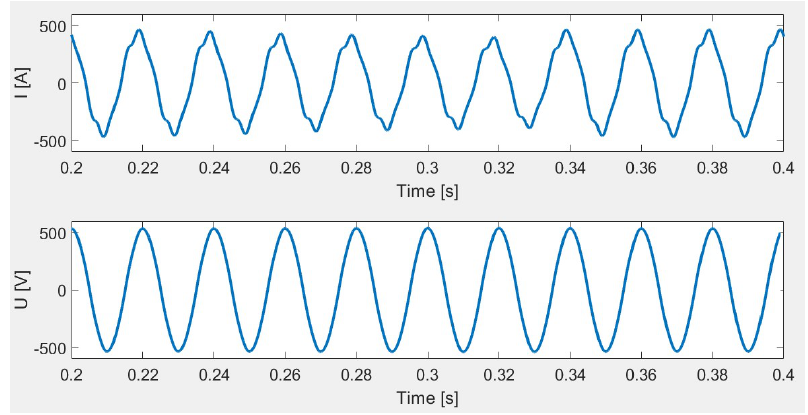
Figure 12. Current and voltage of the transformer supplying four 40 kW AC chargers.